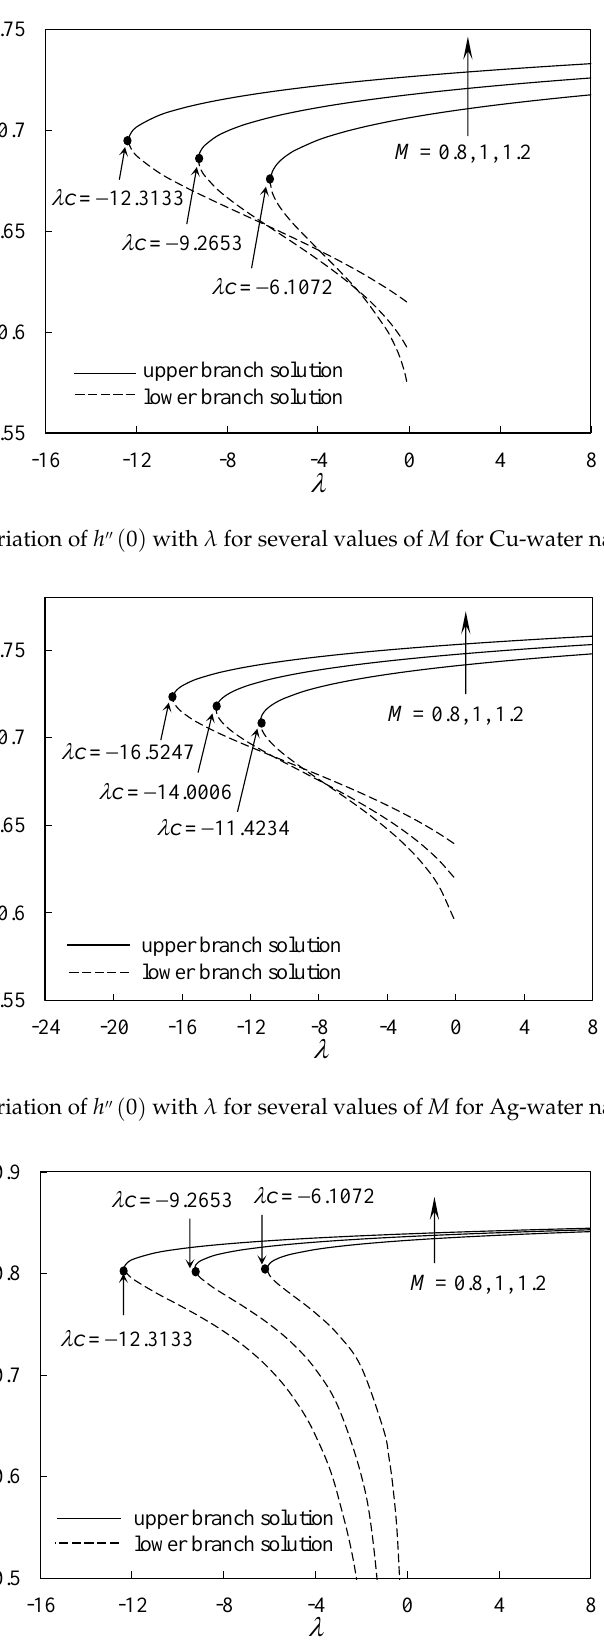
Figure 19. Variation of   0  with  for several values of M for Ag-water nanofluid.